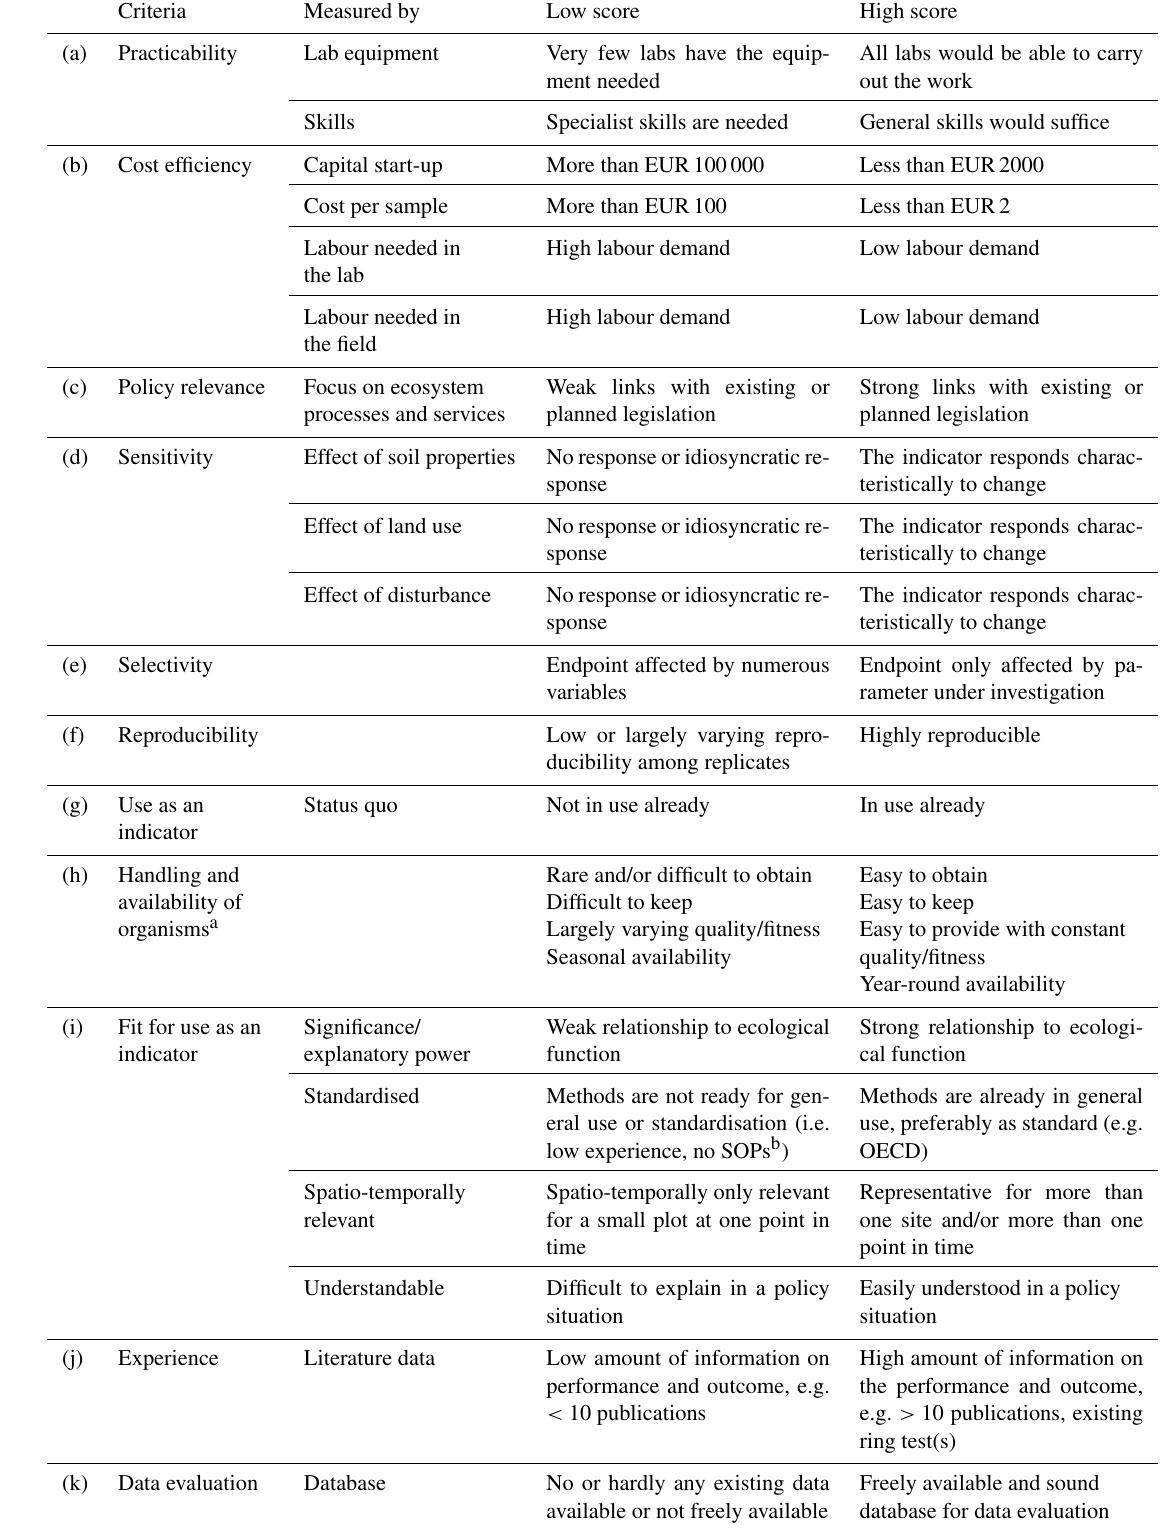
Table 1. List of criteria for the selection of indicators for microbial functional indicators, based on Faber et al. (2013) and Pulleman et al. (2012), with slight modifications by the